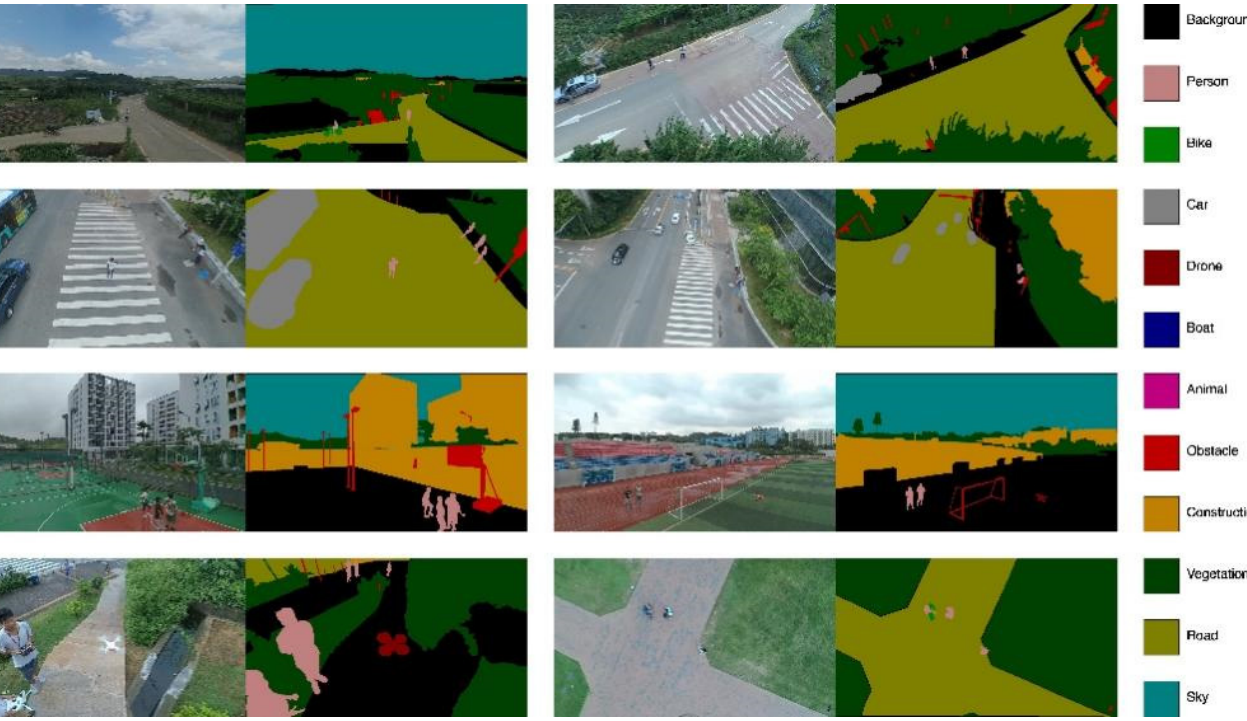
Figure 7. Data enhancement methods.